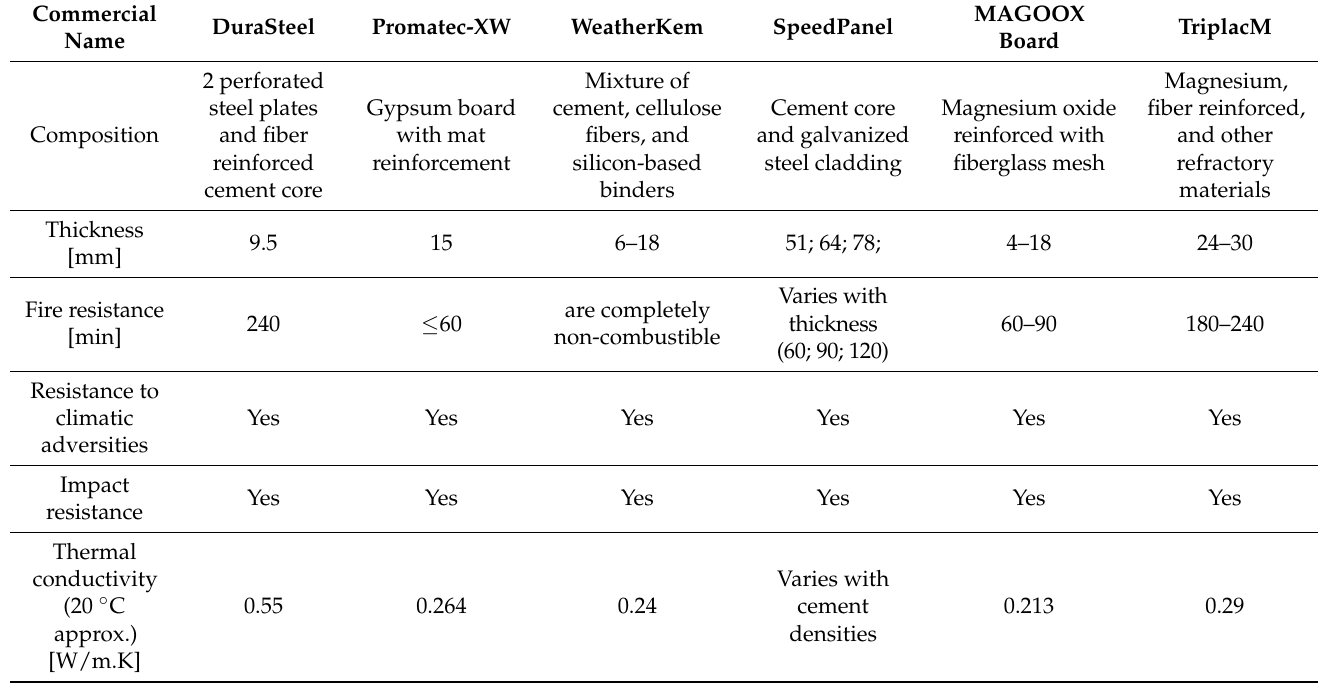
Table 1. Commercial panels identified for the study.